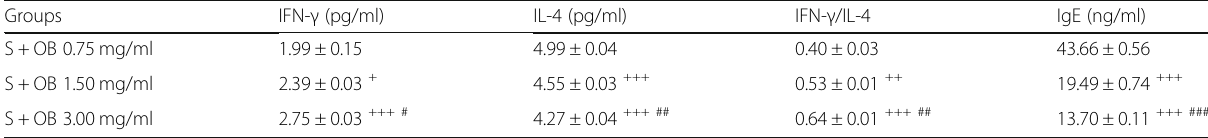
Table 2 IFN- γ , IL-4, IFN- γ /IL-4 and IgE values in sensitized group treated with three different concentrations of O. basilicum (S + OB) Groups